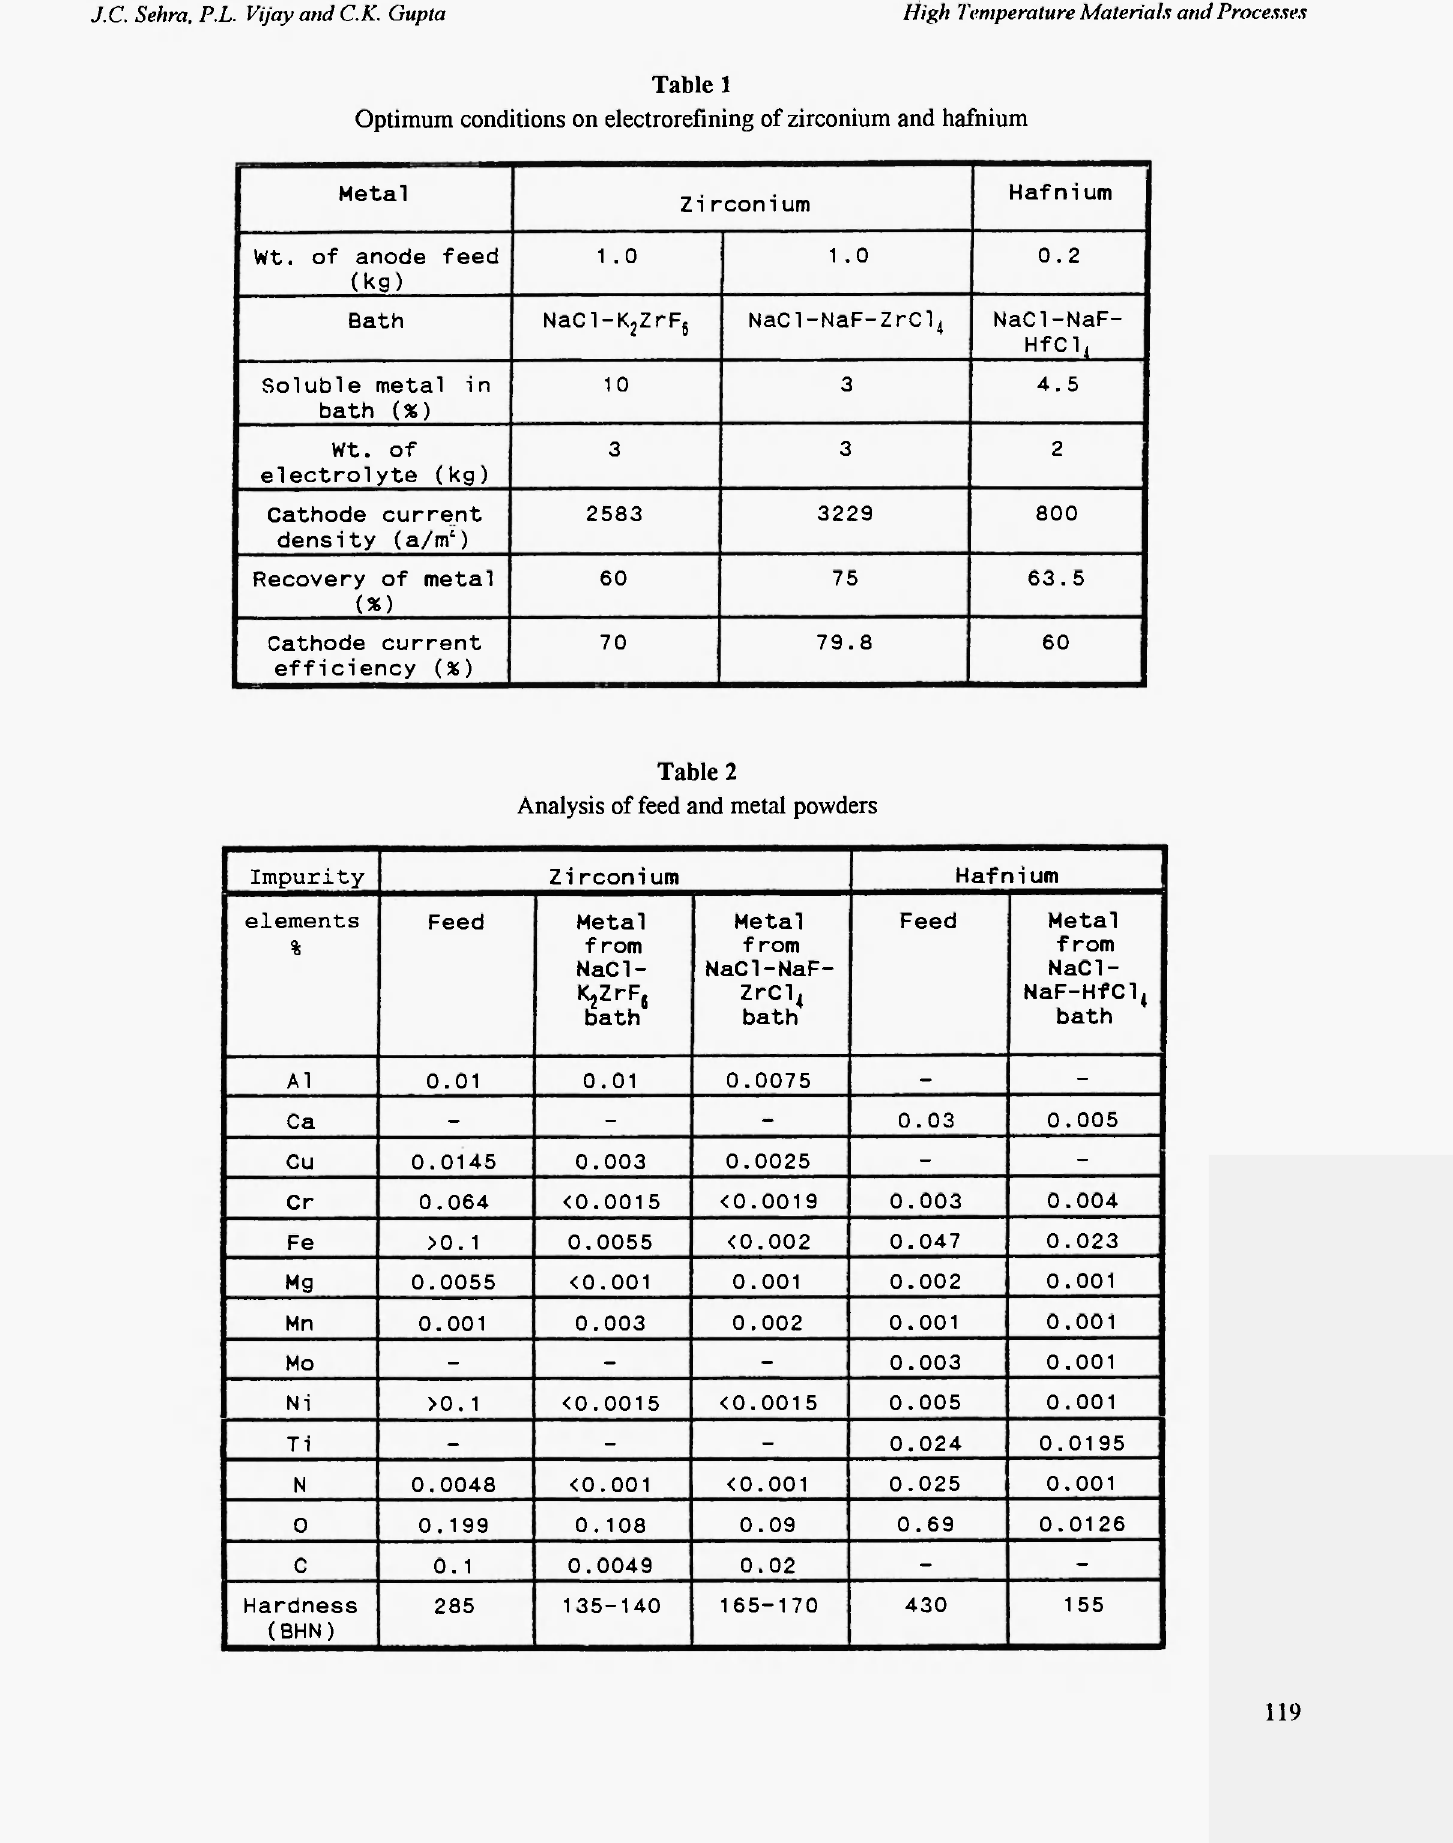
Optimum conditions on electrorefining of zirconium and hafnium